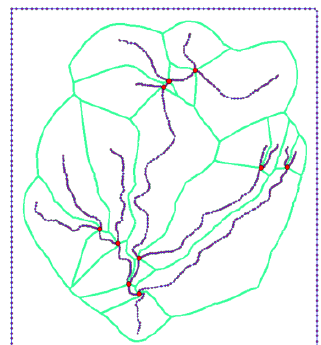
Figure 2. The skeleton extraction of a stream network yields an approximation of the catchment areas